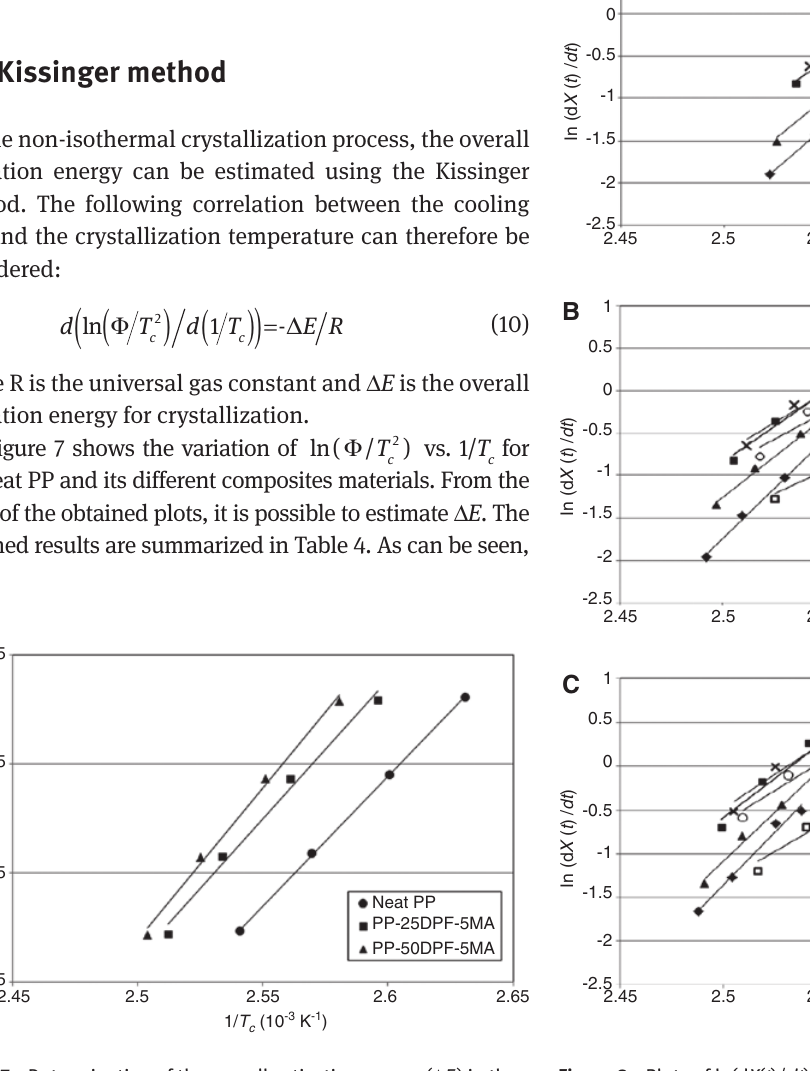
Figure 8: Plots of ln(d X ( t )/ dt ) as a function of 1/ T propylene (PP), (B) PP-25 date palm fiber (DPF)-5MA and (C) PP-50 date palm fiber